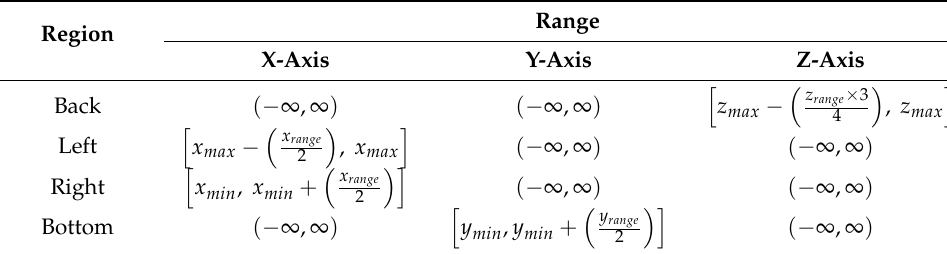
Table 2. Extended ranges for each local region.